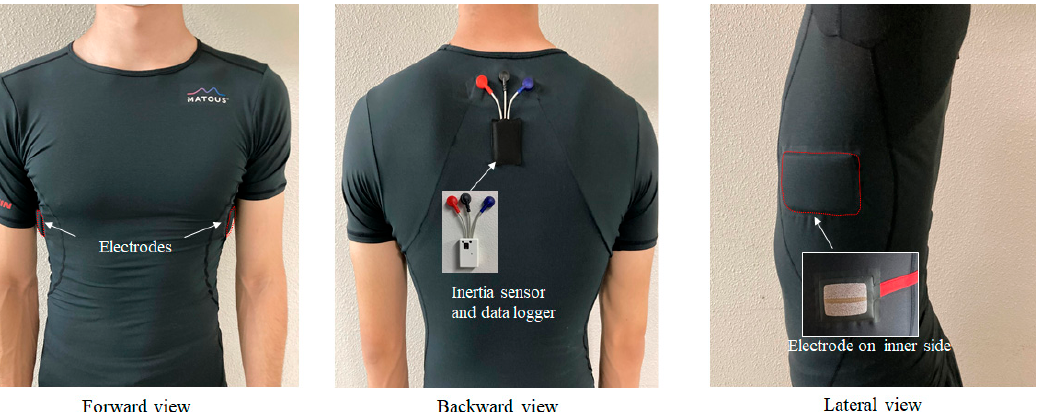
Figure 1. Sportswear-type wearable examined in this study. ECG electrodes are located under each armpit, and the inertial sensor embedded into the data logger is mounted on the upper back.